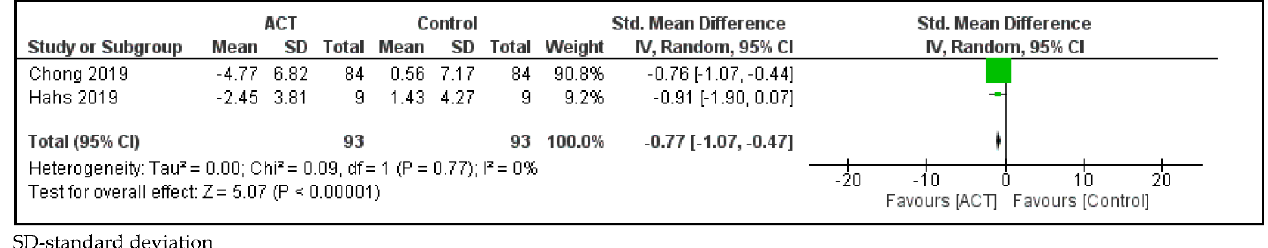
Figure 10. Forest plot comparing acceptance and action questionnaire-II scores between parents of children with SHCN who received ACT and parents of children with SHCN who received no treatment.